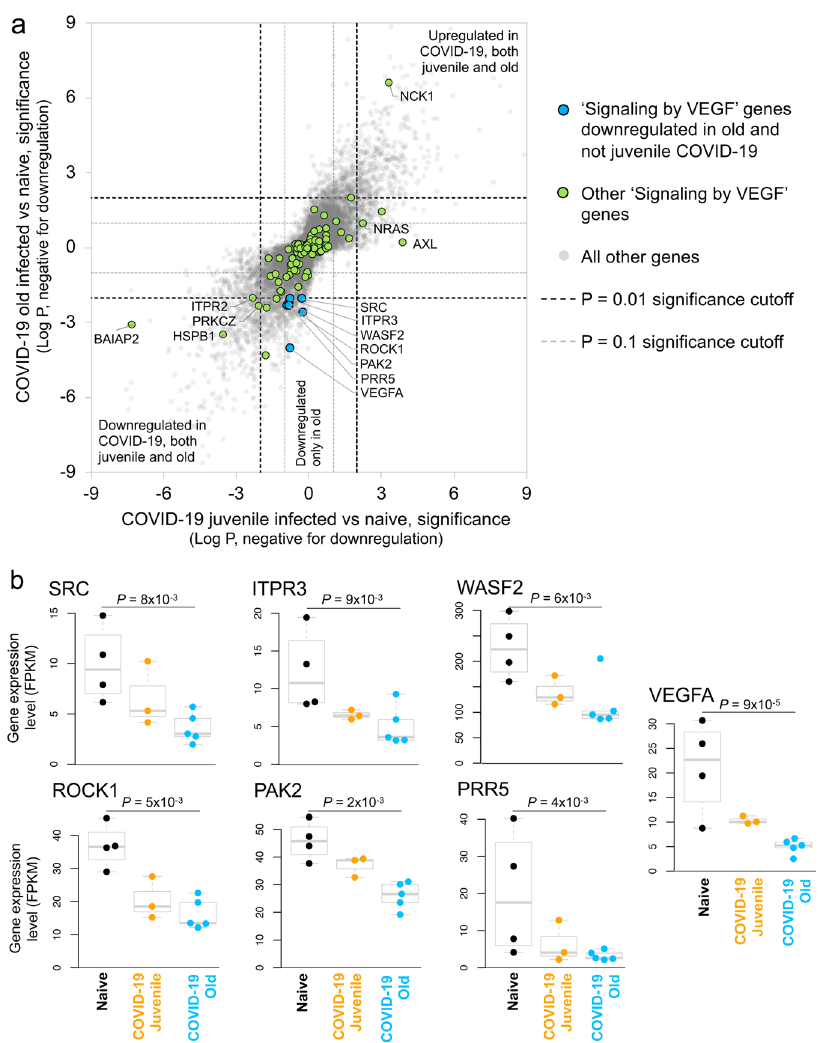
Fig. 7 VEGF pathway genes are signi fi cantly downregulated in old SARS-CoV-2- infected macaques but not juvenile SARS-CoV-2-infected macaques. a Differential expression signi fi cance values for genes from the “ Signaling by VEGF ” (R-HSA-194138) pathway, in both the juvenile vs naive and old vs naive comparisons. Included are signi fi cance values for all genes (gray), pathway genes signi fi cantly downregulated in old but not juvenile (orange) and other pathway genes (green). P value cutoffs (0.01 and 0.1) are indicated with dashed lines. b The relative expression levels (FPKM) for the seven “ Signaling by VEGF ” genes belonging to this gene set are shown. P values represent FDR-corrected signi fi cance values from